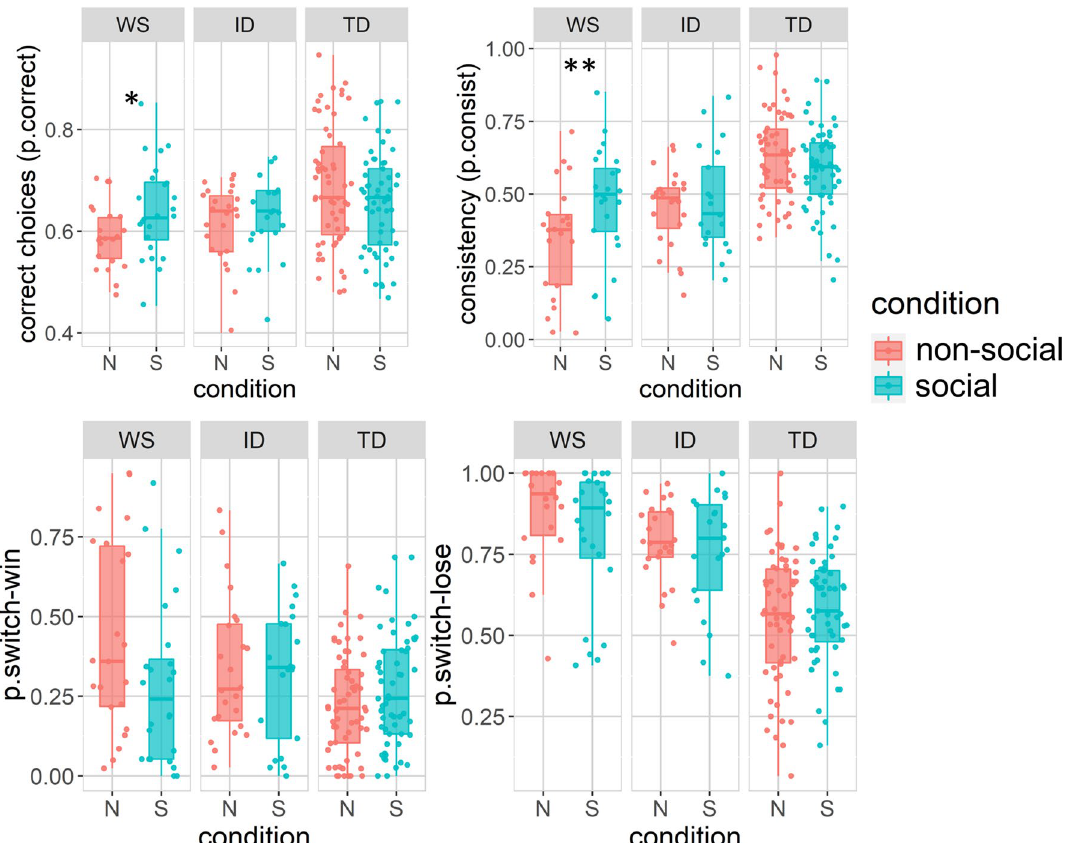
Figure 2. Differences between the social and non-social conditions in choice behavior by group (Stars indicate significant differences from (paired samples t-test, Bonferroni-corrected) for multiple comparisons). Boxplots cover means and 25–75th percentile. *p < 0.05, **p < 0.01. Colored dots show individual participant values.